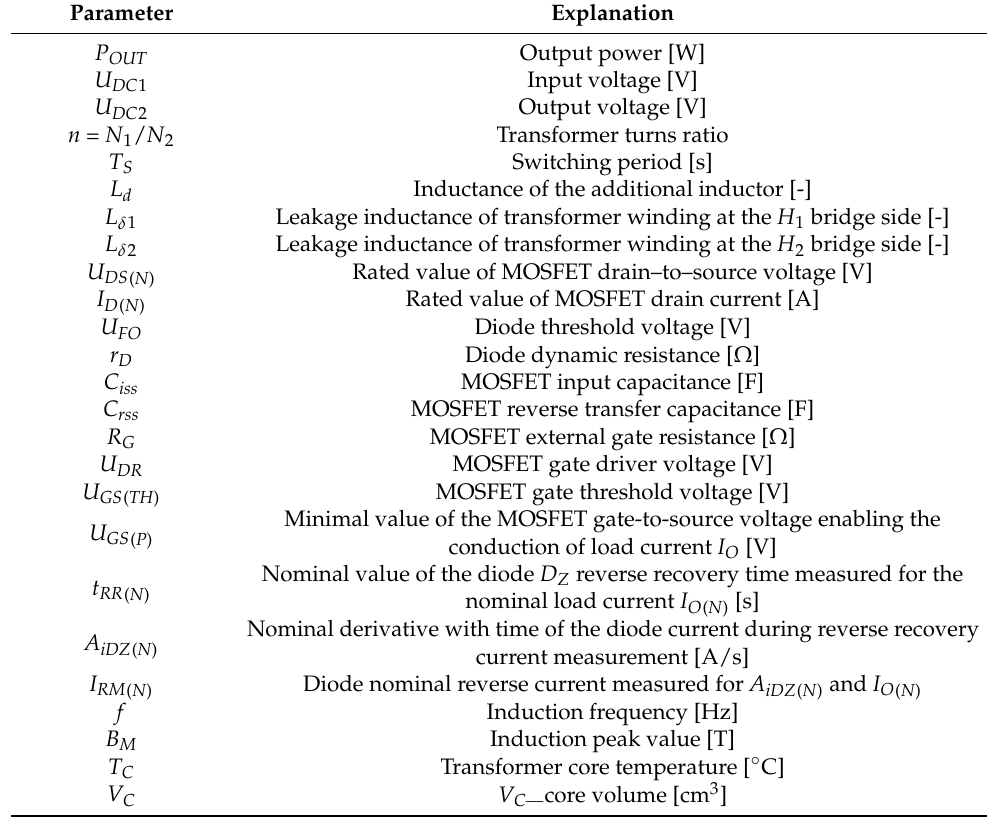
Figure 12. Laboratory setup for the experimental tests: ( a ) Scheme; ( b ) tested DAB converter; ( c ) laboratory stand. Table 1. The parameters required for the DAB efficiency estimation.